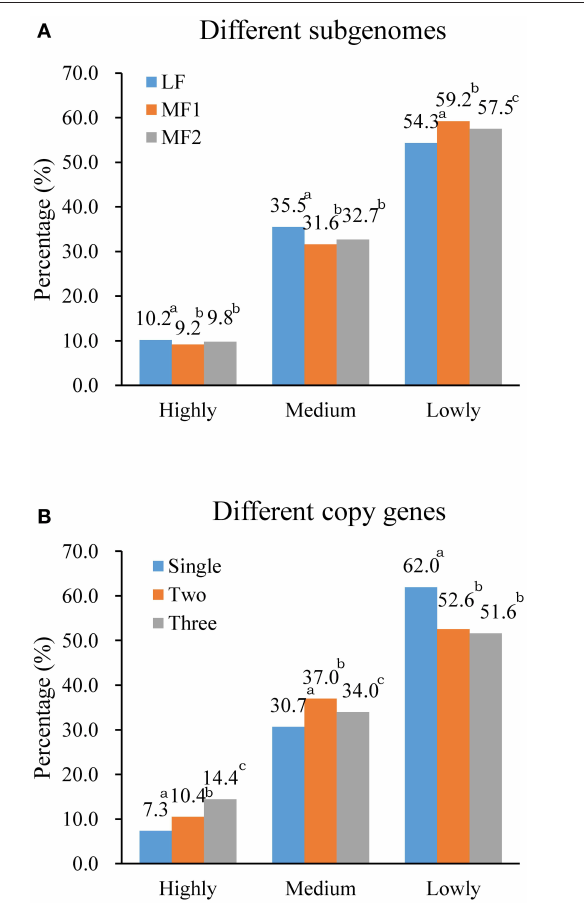
FIGURE 6 | Differential gene expression (A) between three subgenomes and (B) between different copy genes. Expressed genes were collected into lowly ( ≤ 5), medium (5 < RPKM ≤ 50) and highly ( > 50) groups according to RPKM value. Superscript a, b, c indicated the significance of gene expression level with different copies or within different